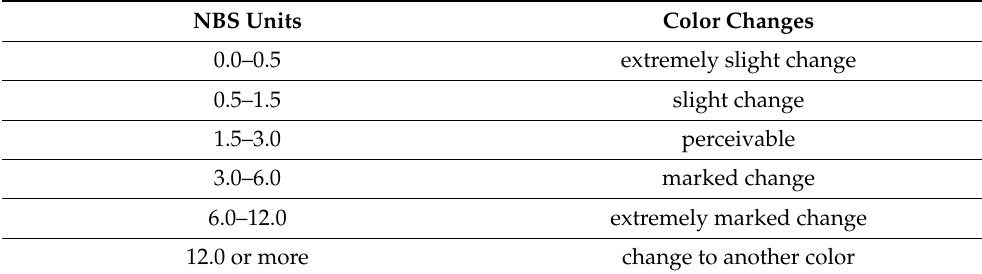
Table 2. Levels of color change, according to